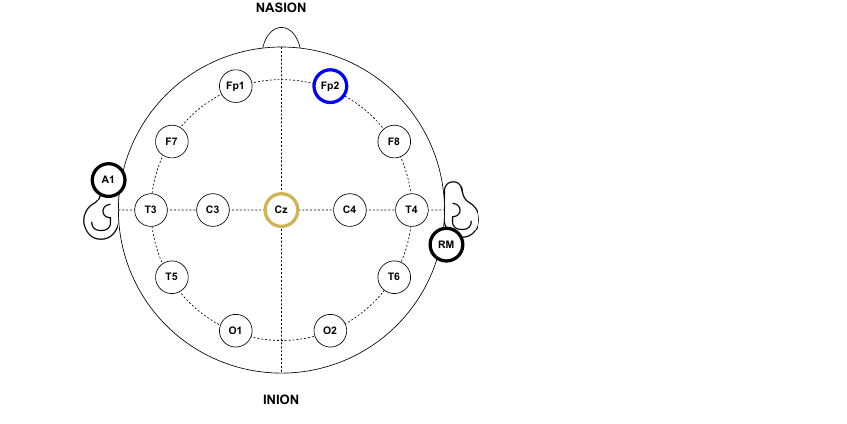
Figure 5. Anatomical electrode distribution in accordance with the standard 10–20 placement system used during the experiments. The yellow circle represents the input channel for EEG recordings, while the blue one corresponds to EOG recordings. Black bordered circles represent reference and ground